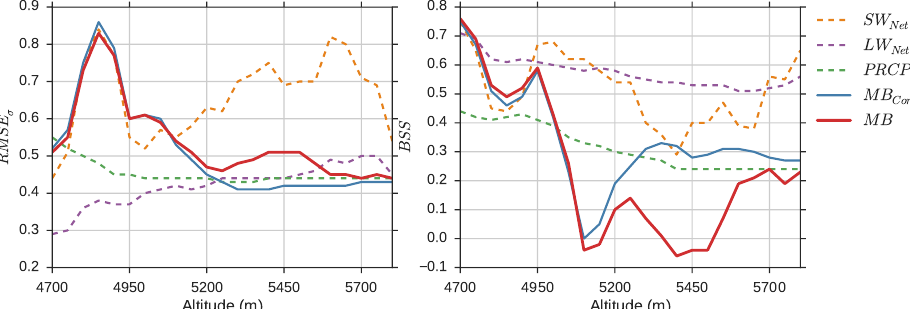
Figure 9. Out-of-sample cross-validation scores for selected variables and for each 50m altitude slice at Shallap Glacier. Left: RMSE expressed in % of the standard deviation σ . Right: Brier skill score